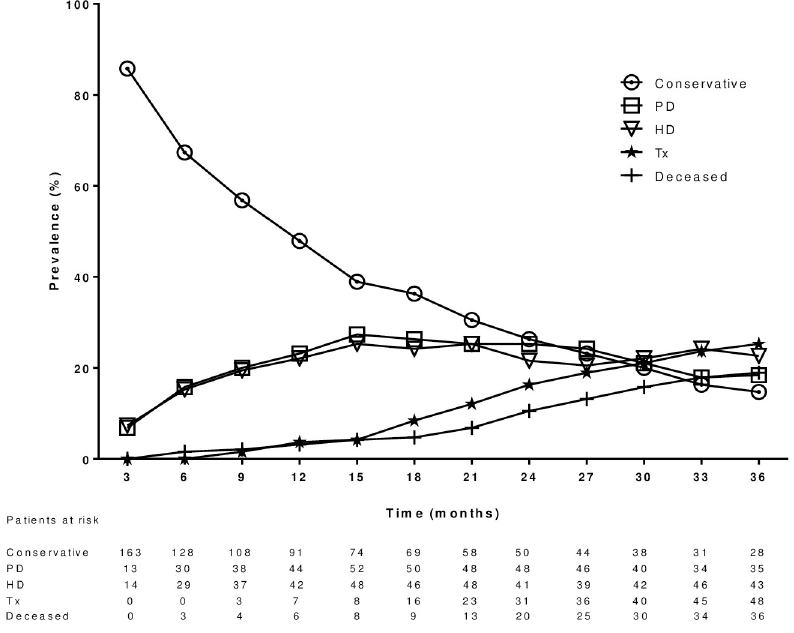
Fig 2. The clinical course of the study patients through follow-up. PD = Peritoneal dialysis; HD = hemodialysis; Tx = Kidney transplantation.